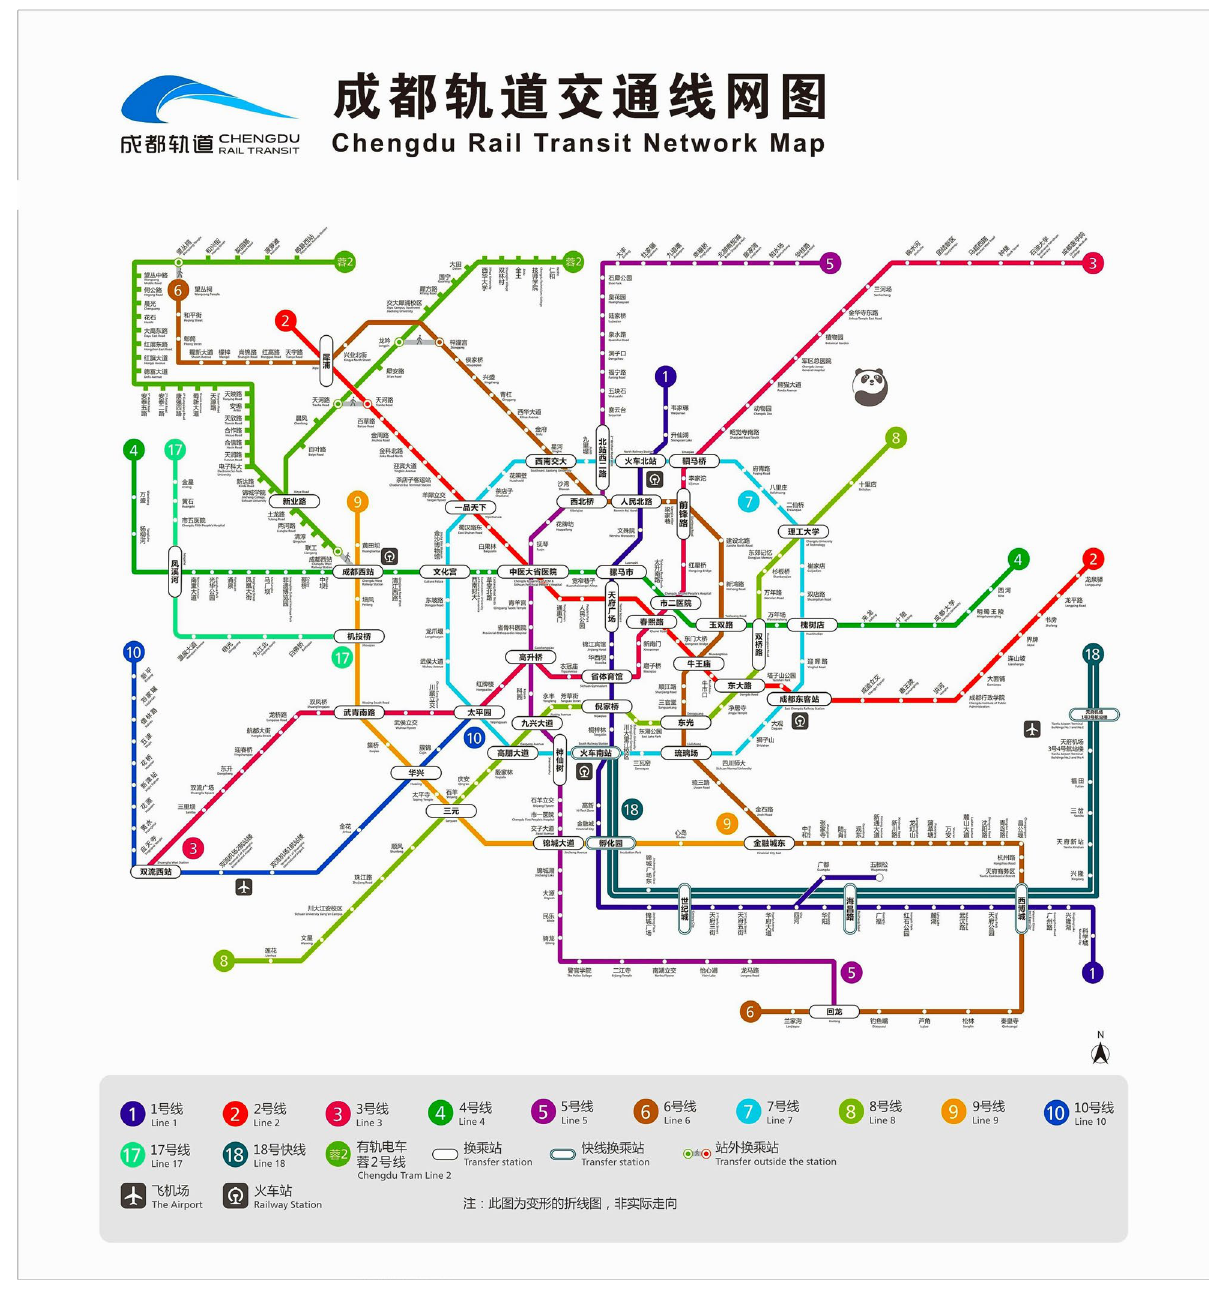
Figure 5. Chengdu rail-transit network and